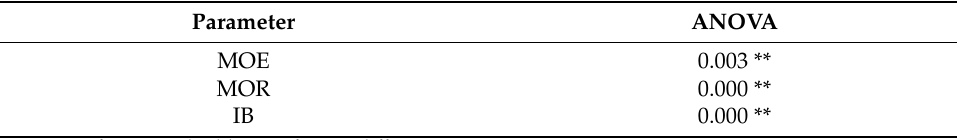
Figure 5. Effect of wood shaving on MOE and MOR of elephant dung particleboard. Table 6. Variance analysis summary of mechanical properties.